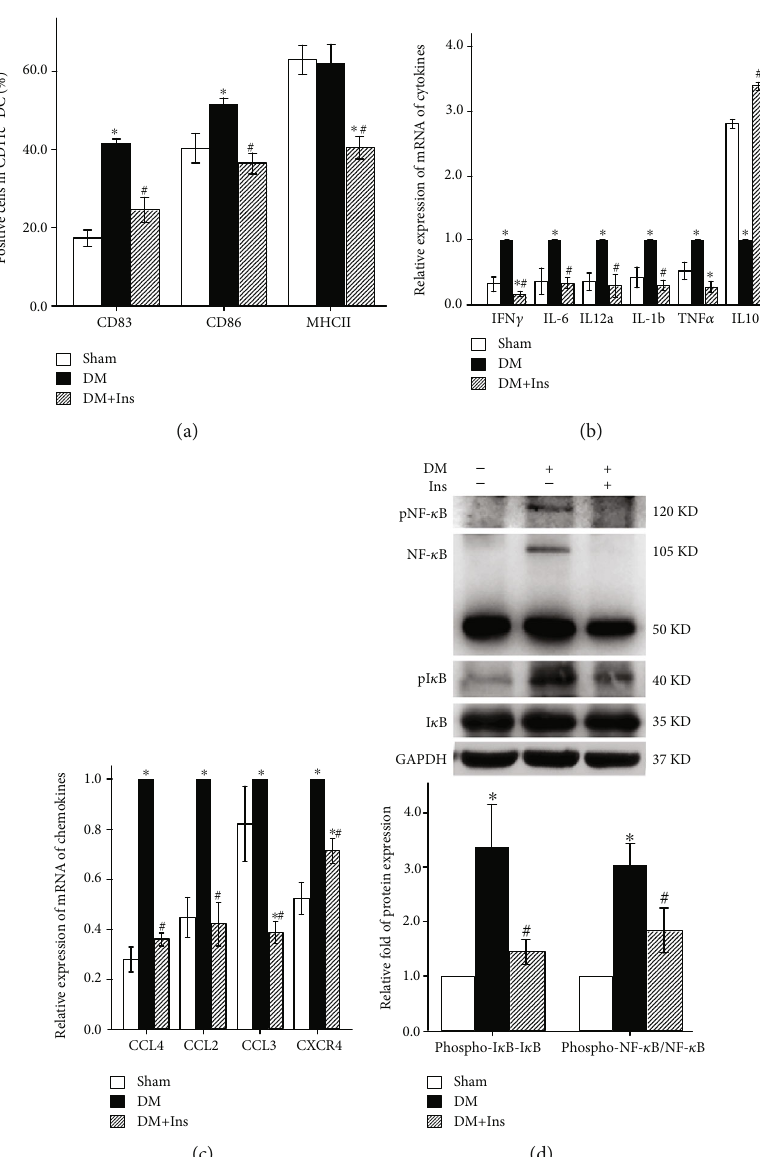
Figure 2: Insulin therapy inhibiting the immune in fl ammatory response of spleen DCs in DM mice. (a) Expressions of cell surface CD83, CD86, and MHC-II of spleen DCs as determined by fl ow cytometry. (b, c) Expressions of the cytokines and chemokines in spleen DCs were analyzed by quantitative real-time RT-PCR. Insulin treatment reduced the elevation of proin fl ammatory cytokines and chemokines in DM mice; insulin treatment reversed decline in anti-in fl ammatory factor IL-10 in DM mice. (d) Representative immunoblot analysis of NF- κ B and I κ B by western blot suggested the activation of NF- κ B and I κ B was suppressed by insulin treatment. Data are expressed as mean ± SED ; n = 5 ; ∗ p < 0 : 05 vs. Sham group; # p < 0 : 05 vs. DM group. DCs: dendritic cells; DM: diabetes mellitus; TNF- α : tumor necrosis factor- α ; IFN- γ : interferon- γ ; MHC-II: major histocompatibility complex-II; NF- κ B: nuclear factor- κ